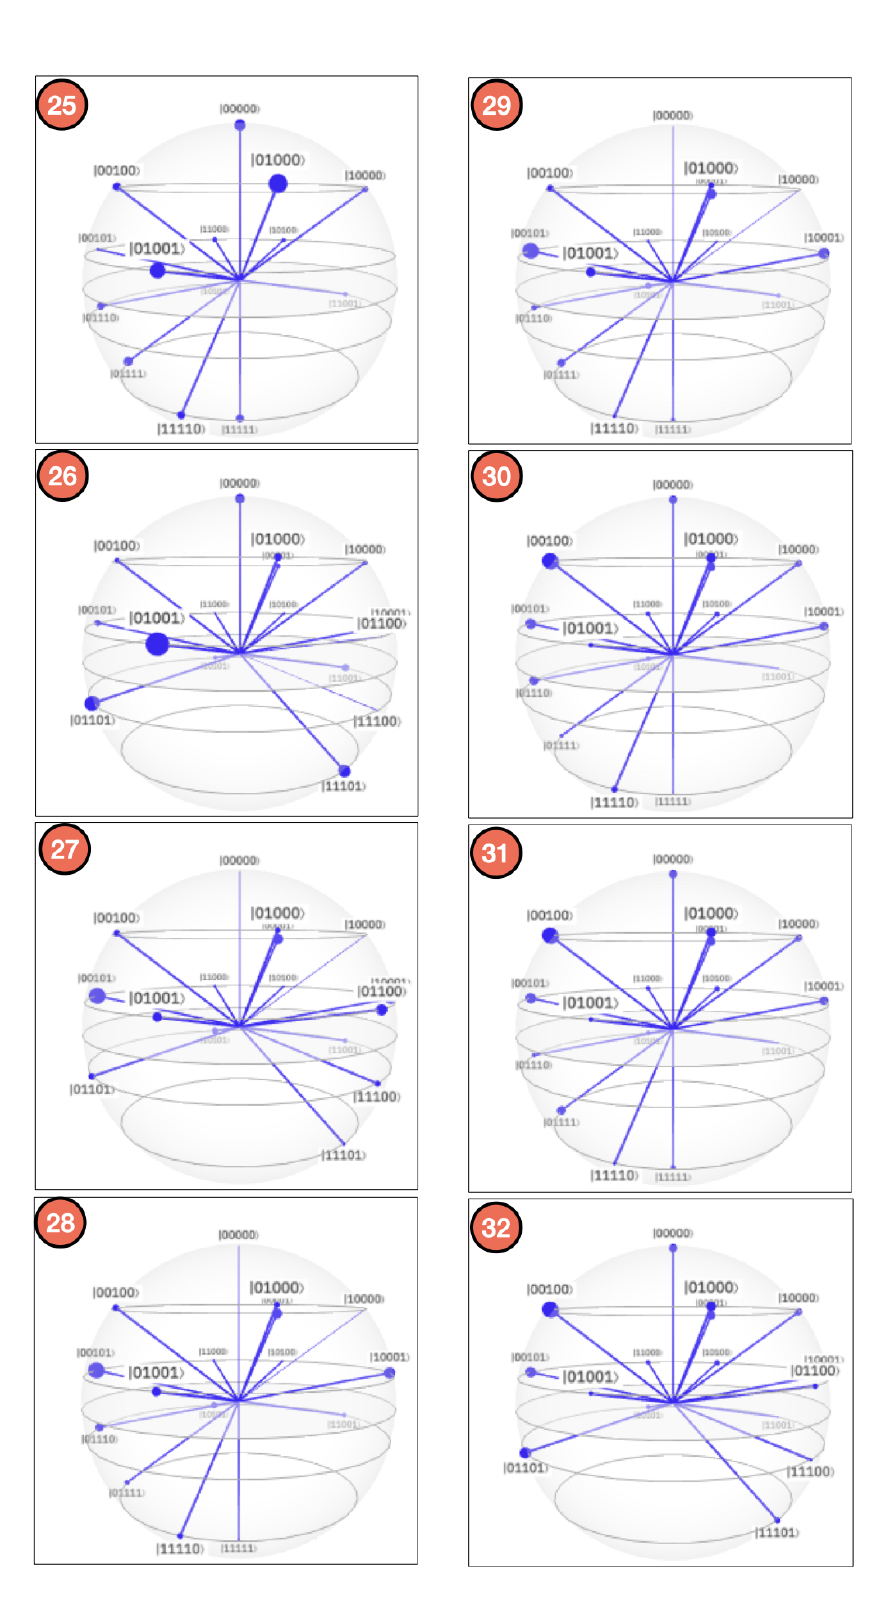
Figure A4. QSOD Bloch sphere measurements steps